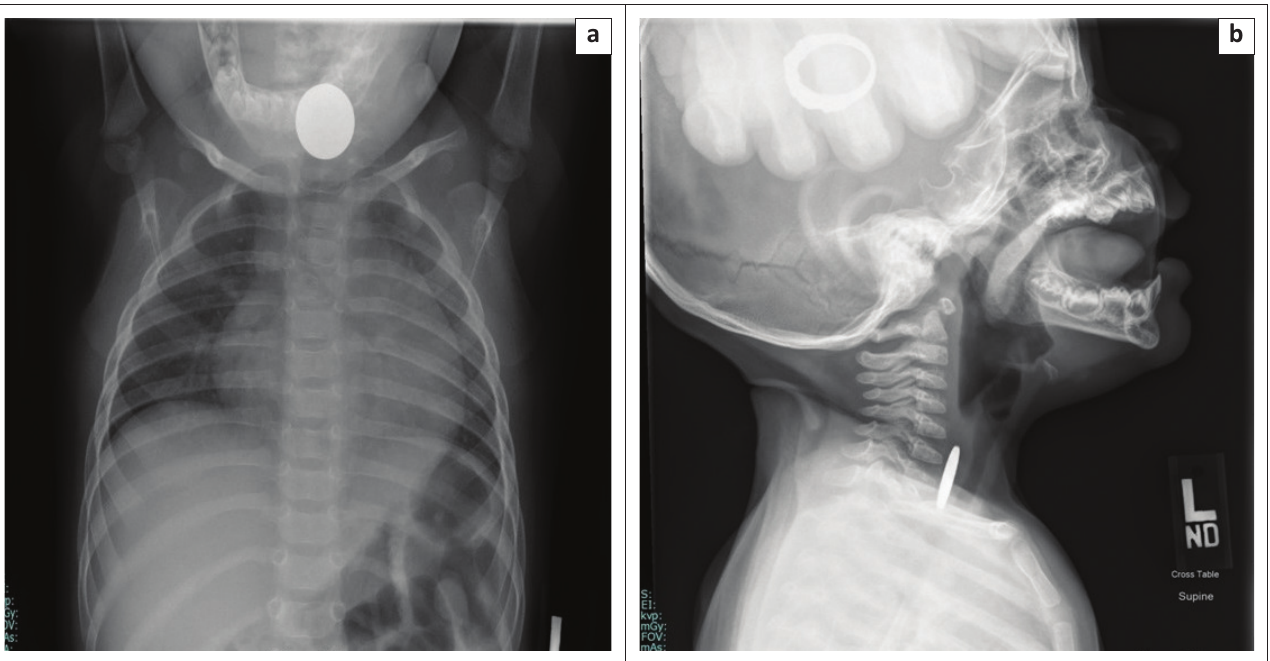
FIGURE 1: Frontal (a) and lateral (b) radiographs of the neck reveal a swallowed coin in the proximal oesophagus of a 10-month-old child who presented with respiratory distress and drooling.